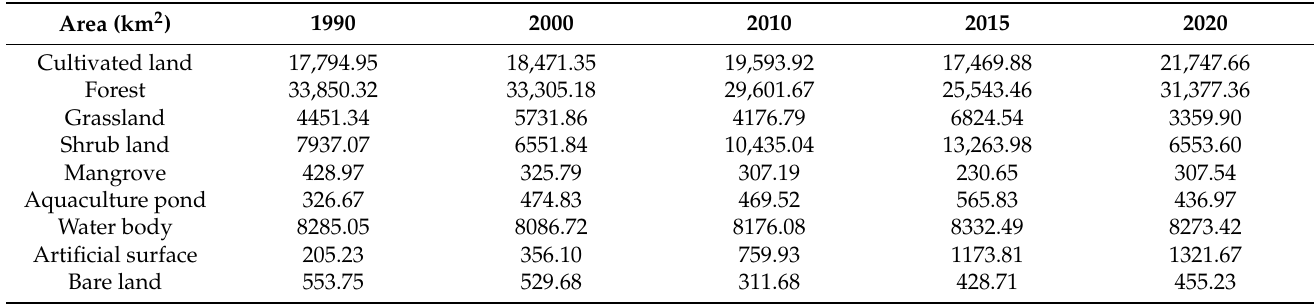
Table A1. Area statistics of land cover types in Sri Lanka between 1990 and 2020.